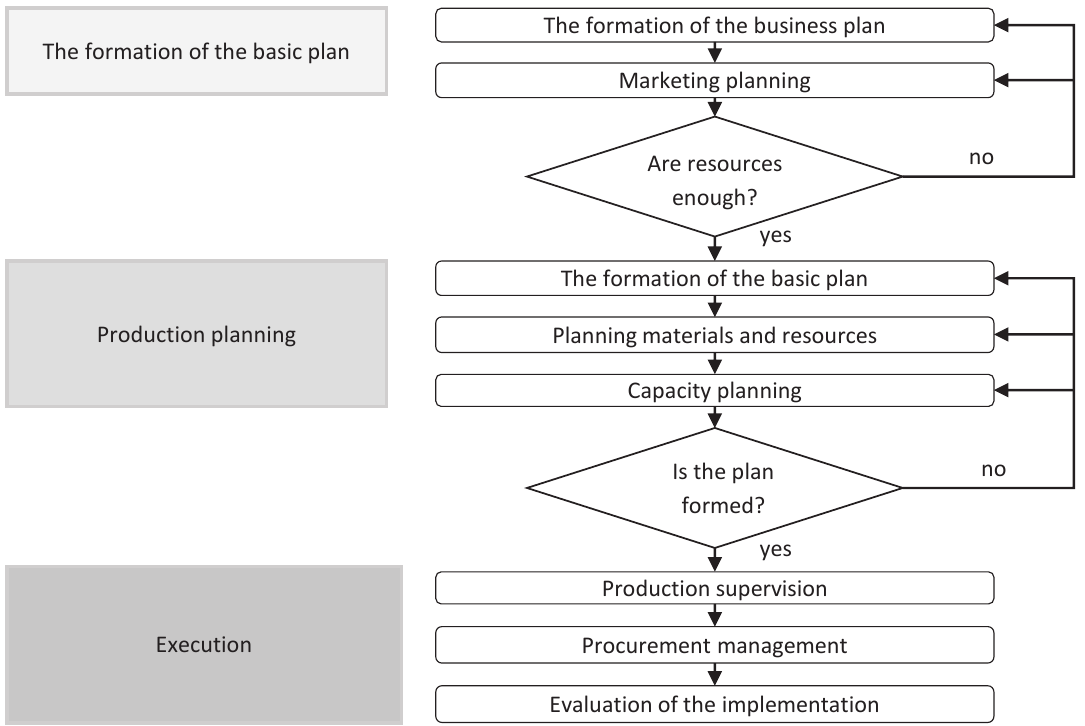
Figure 3. The algorithm of the interaction model functional modules in